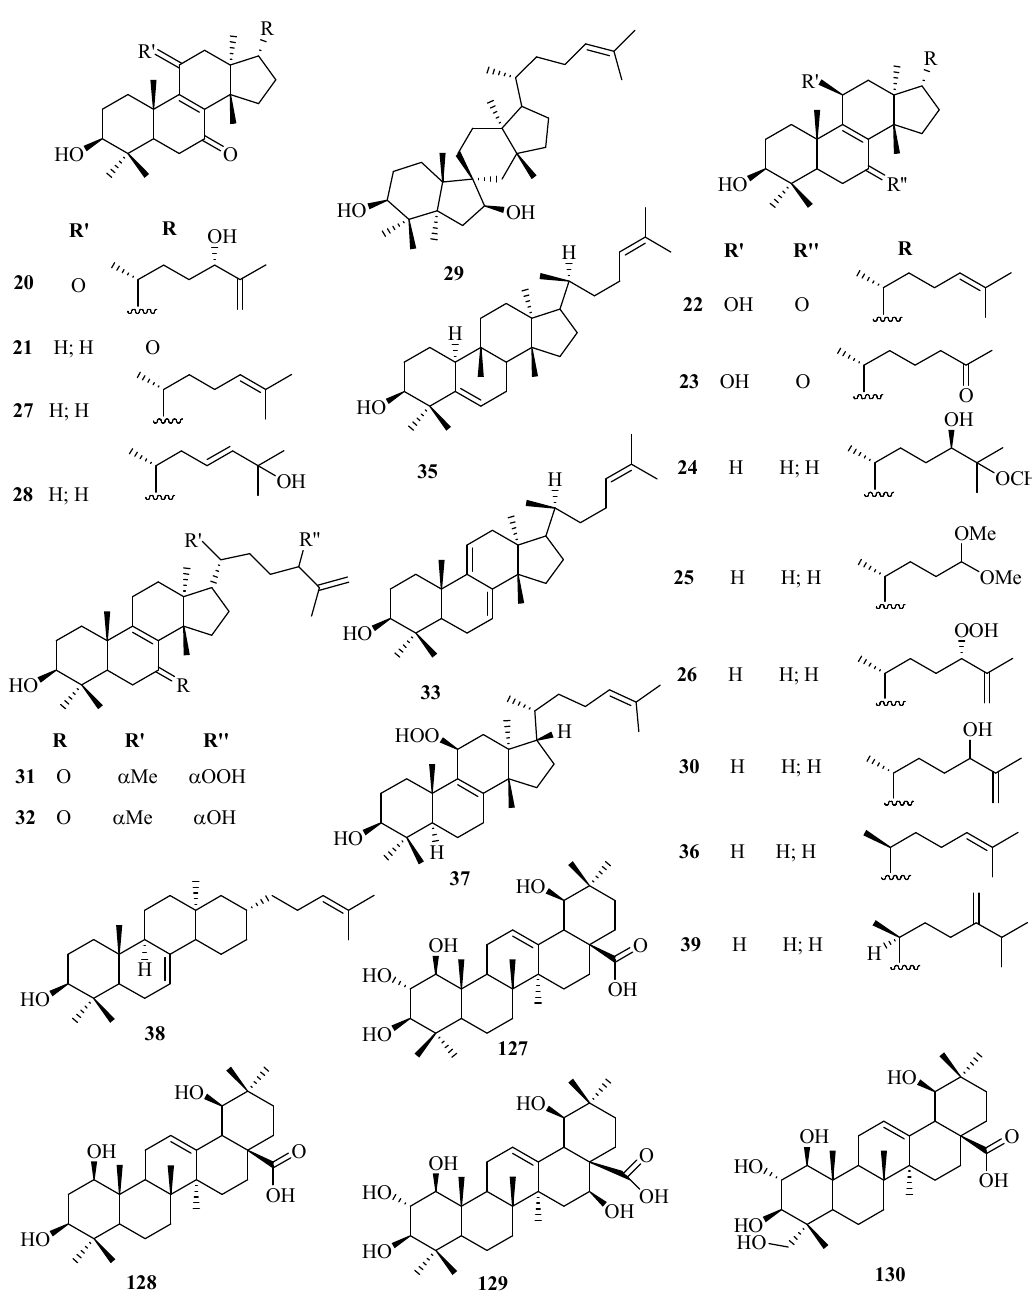
Figure 2. Structures of Euphane and some oleanane triterpenoids isolated from genus Euphorbia.